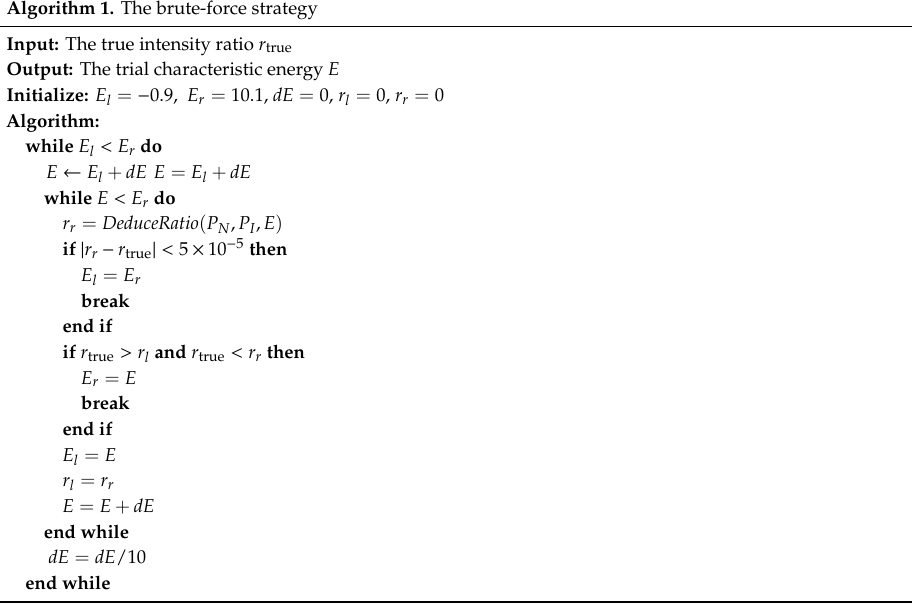
Algorithm 1. The brute-force